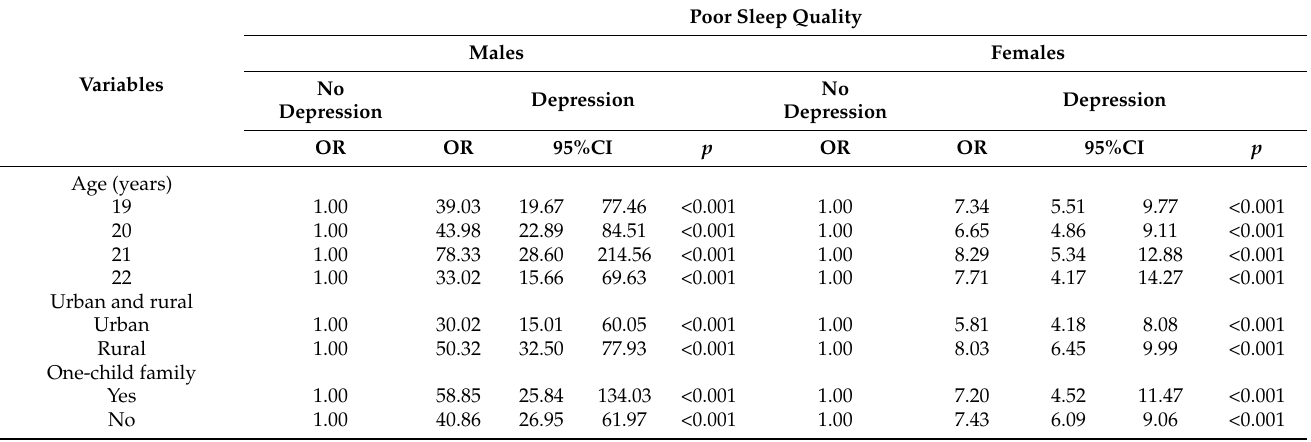
Table 4. Subgroup analysis of the relationship between sleep quality and depressive symptoms in college students with different